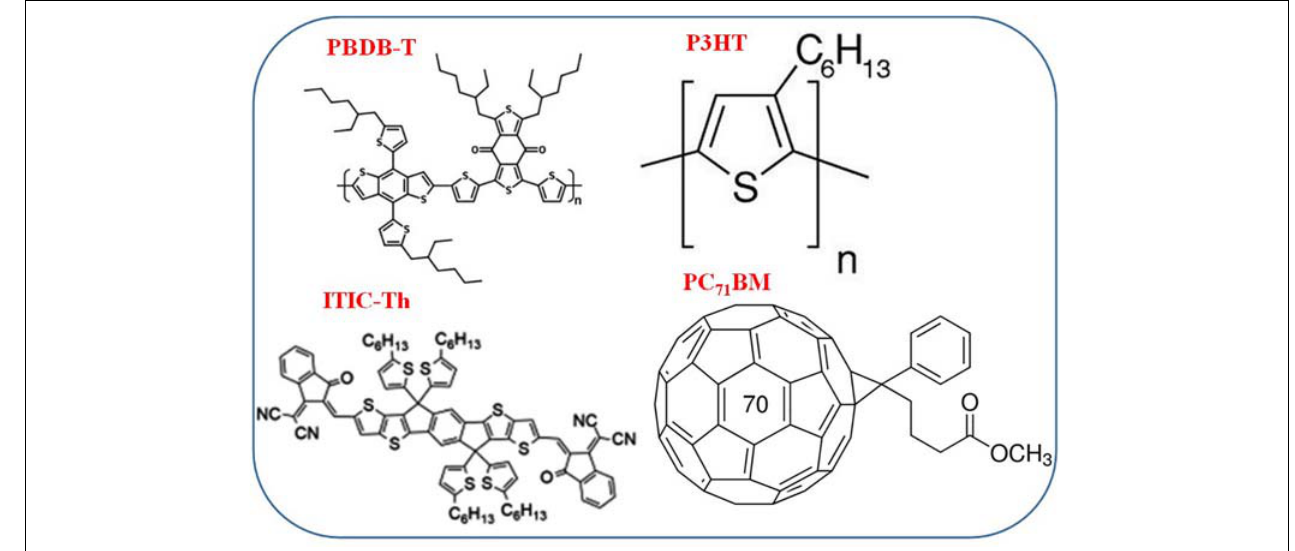
FIGURE 1 | Chemical structure of donor materials PBDB-T, P3HT, and acceptor ITIC-Th and PC 71 BM.